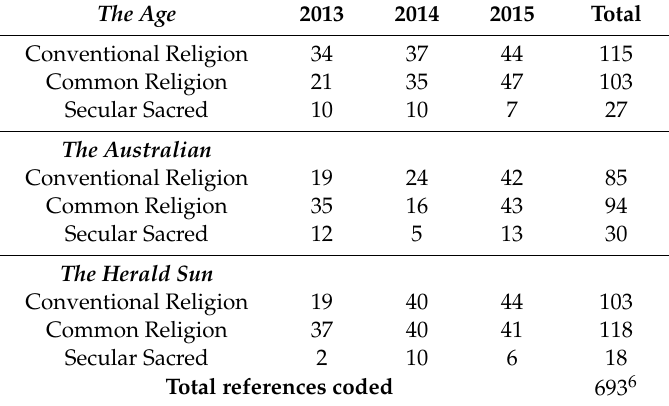
Table 1. The number of references coded per newspaper based on the categories of religion over a three-year period from 2013 to